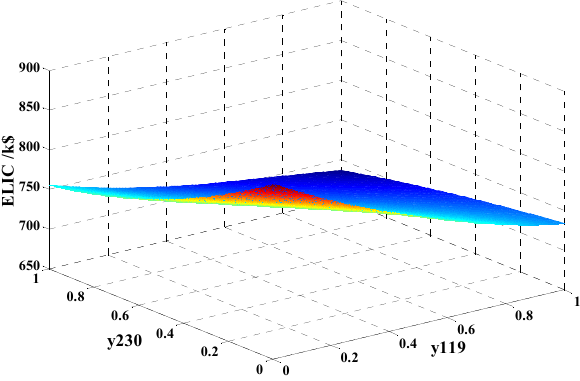
Figure 6. The value of ELIC impace with y 119 and y 230 .